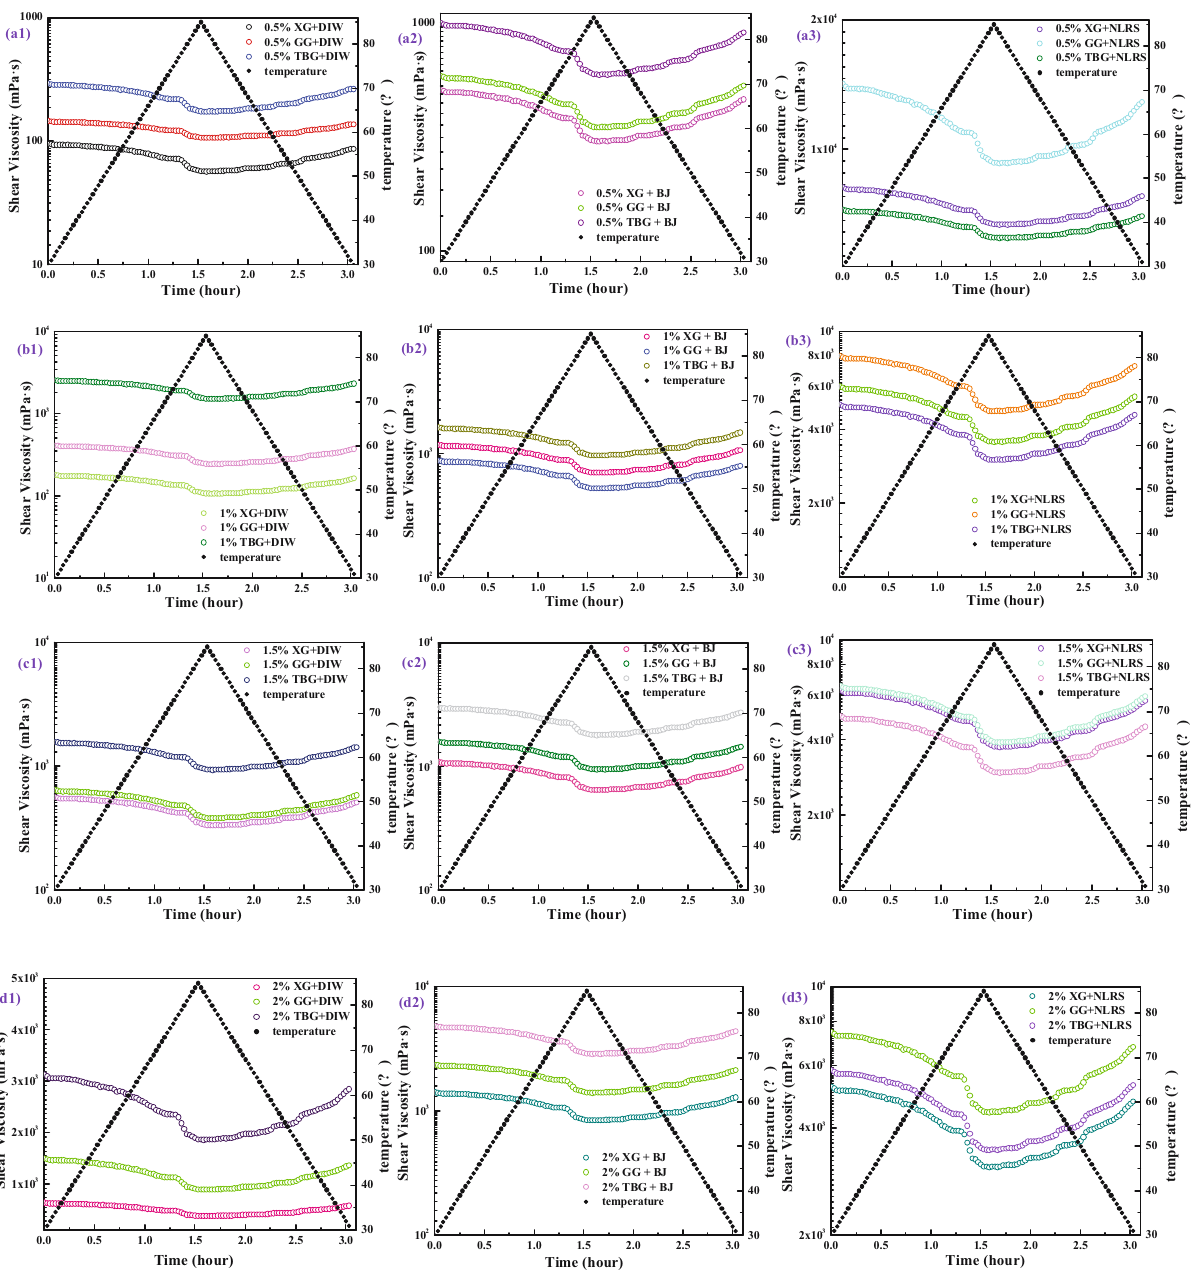
Figure 7: Di ff erent concentrations and di ff erent dispersion media, pasting properties curve. ( a1 ) 0.5% thickening gel + DIW, ( a2 ) 0.5% thickening gel + BJ, ( a3 ) 0.5% thickening gel + NLRS, ( b1 ) 1% thickening gel + DIW, ( b2 ) 1% thickening gel + BJ, ( b3 ) 1% thickening gel + NLRS, ( c1 ) 1.5% thickening gel + DIW, ( b2 ) 1.5% thickening gel + BJ, ( b3 ) 1.5% thickening gel + NLRS, ( d1 ) 2% thickening gel + DIW, ( d2 ) 2% thickening gel + BJ, ( d3 ) 2% thickening gel +